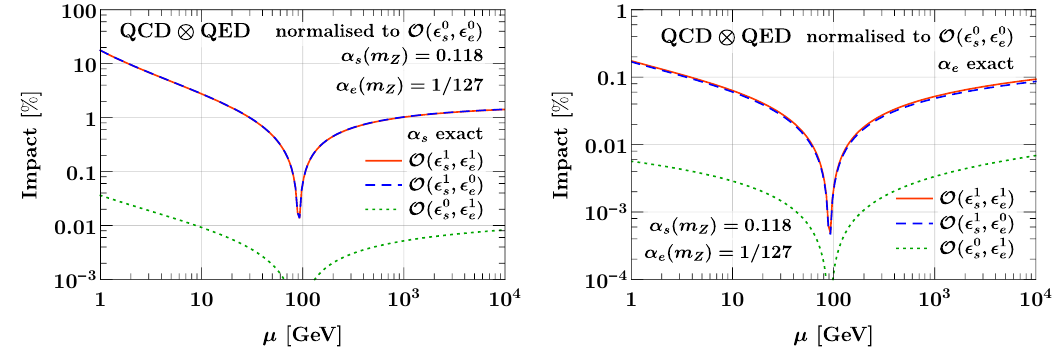
Figure 3 . Impact of di(cid:11)erent higher-order terms on the running of the QCD (left) and QED (right) couplings. Shown are the relative di(cid:11)erences to the LO running (cid:24) O ( (cid:15) 0